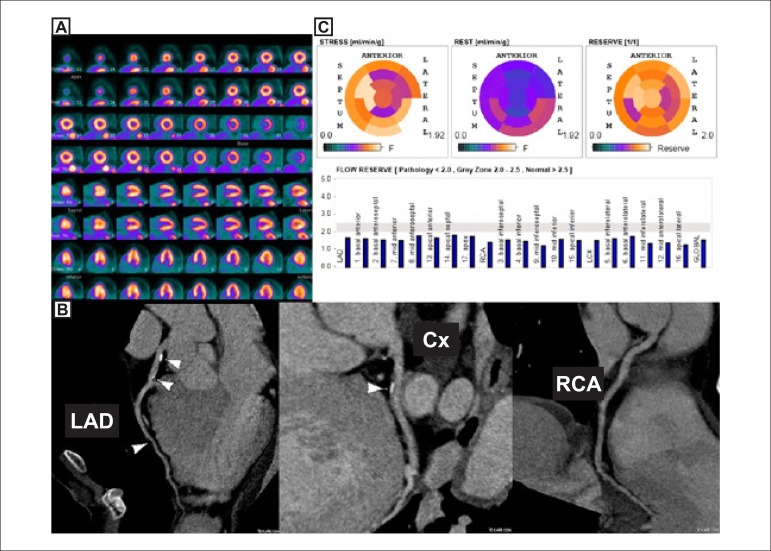
A 53-year old patient, of pardo race, with chronic renal insufficiency, undergoing hemodialysis, and left ventricular hypertrophy. Pre-renal transplant evaluation. Counterclockwise: A) PET perfusion with rubidium-82 with no segmentary defects in uptake between different walls of the left ventricle. B) Coronary tomography with evidence of parietal calcium in the anterior descending and circumflex arteries, but no obstructive lesions. C) Quantification of myocardial blood flow and flow reserve, widely reduced throughout all coronary territories (In the bar graph, coronary flow values < 2.0 ml.min-1.gram-1 of myocardium are considered abnormal; values between 2.0 and 2.5 ml.min-1.gram-1 are considered in the gray zone; and values > 2.5 ml.min-1.gram-1 are considered normal), notwithstanding the absence of obstructive epicardial disease, are indicative of microvascular disease. LAD: left anterior descending; Cx: circunflex; RCA: rigth coronary artery.